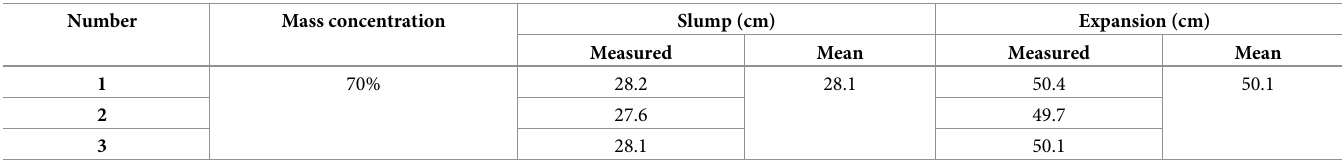
In the direction parallel to the infiltration direction, the water-cement ratio gradually increases with the diffusion distance. The water-cement ratio near the grouting hole is less than the ini- tial water-cement ratio, the near-end water-cement ratio is small, and the far-end water- cement ratio is large. The experimental results also verify the correctness of the theoretical analysis. According to the screening results, the proportion of fine particles smaller than 200 mesh in the flow direction of the gangue slurry has increased. The proportion of coarse particles larger than 200 mesh in the corresponding flow direction has decreased, indicating that the solid particles in the gangue slurry appear to be a particle sorting phenomenon due to the influence of the seepage effect in the flow process of the goaf. The main reasons for this phe- nomenon are: the slurry is mainly distributed in the cavities composed of each rock block and the voids between each rock block. The slurry in different cavities is in a polarized state. When the cavity is filled with slurry, the voids between rock blocks around the cavity are filled with slurry, but there are still some small voids without a slurry. When there is no slurry in the cav- ity, the slurry in the interstices between the rock blocks around the cavity is distributed as a broken branch. That is, the slurry blocks the crevices between the rock blocks (there are large Table 2. Test results of slump and